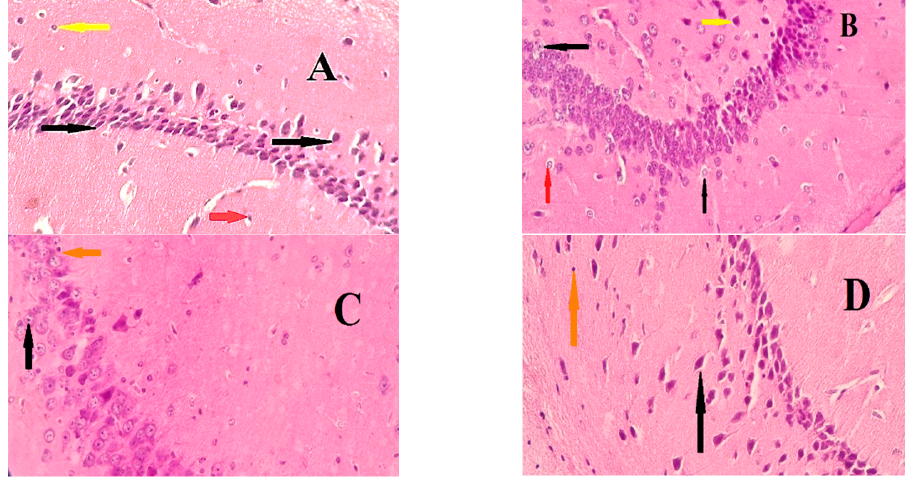
Figure 2. Microscopic sections of the rat hippocampus: ( A ) section from the normal control group, showing a regular cellular architecture with pyramidal cells (black arrow), astrocytes (red arrow) and microglial cells (yellow arrow); ( B ) section from the positive control group, demonstrating degenerated neurons with shrunken nuclei (black arrow), numerous hyperchromatic astrocytes with a vacuolated cytoplasm (red arrow) and hyperchromatic microglial cells (yellow); ( C , D ) normal pyramidal cells with some neurons that are pyknotic (black arrows) and astrocytes with a vacuolated cytoplasm (orange arrow).